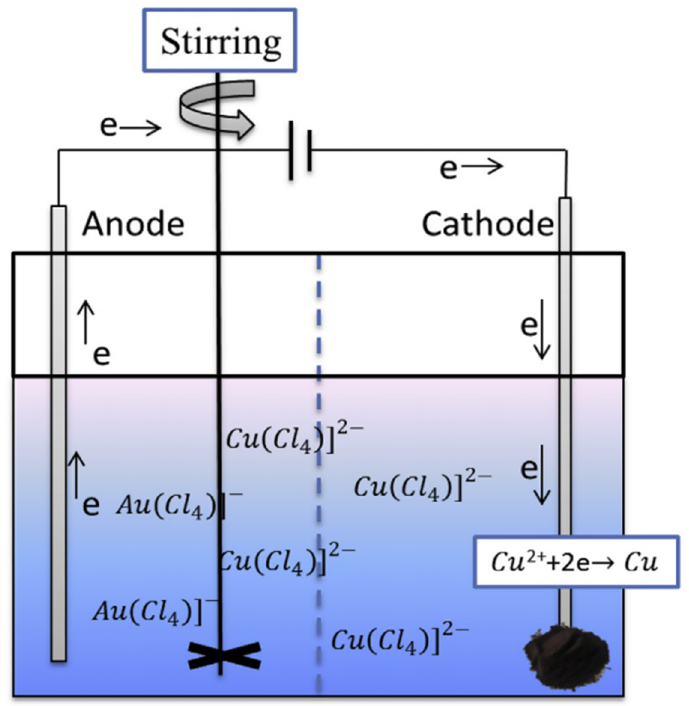
Figure 11. Schematic diagram of the electrodeposition process in HCl-NaCl-H 2 O 2 system. Repro- duced with permission [81]. Copyright 2019, Elsevier.